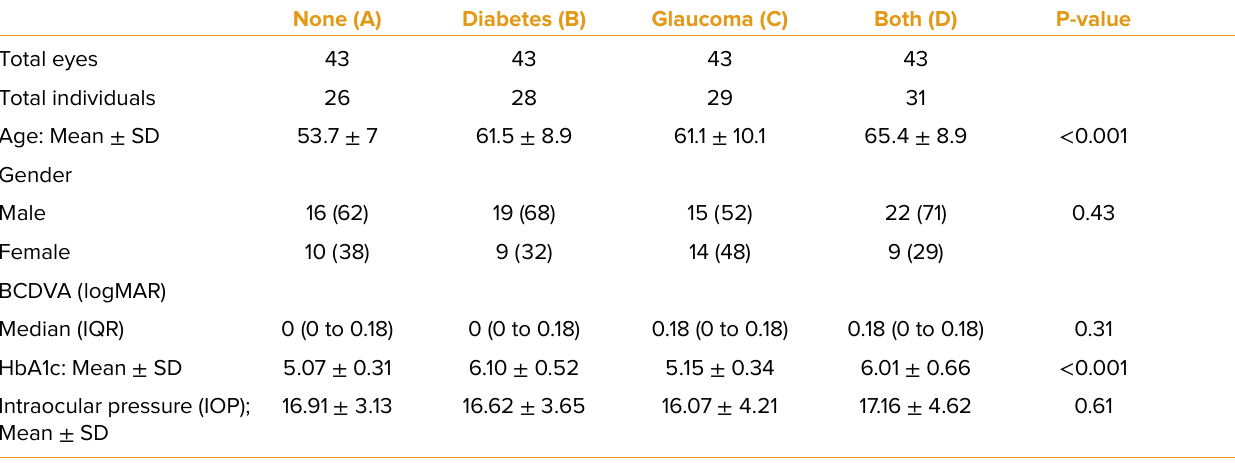
Table 1. Table showing the demographic and clinical characteristics of 172 eyes, India.